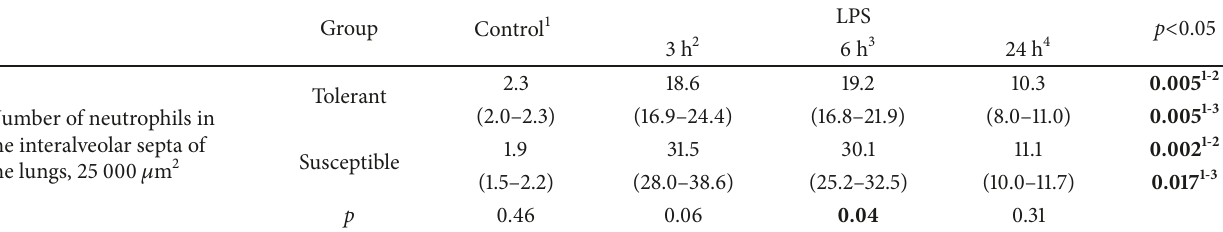
Figure1:Endotoxinserumlevelsintolerant-andsusceptible-to-hypoxiaratsafter3,6,and24hoursofLPSadministration.Dataarepresented as median (25%, 75%); the statistical significance of differences ( p ) is determined by the Kruskal-Wallis method ( 𝑛 = 5 in each group). Table 1: The number of neutrophils in the interalveolar septa in the lungs of tolerant- and susceptible-to-hypoxia rats after 3, 6, and 24 hours of LPS administration. Data are presentedas median (25%, 75%); the statistical significance of differences ( p ) between tolerantand susceptible rats is determined by the Mann-Whitney U test and between different time points after LPS injection by the Kruskal-Wallis